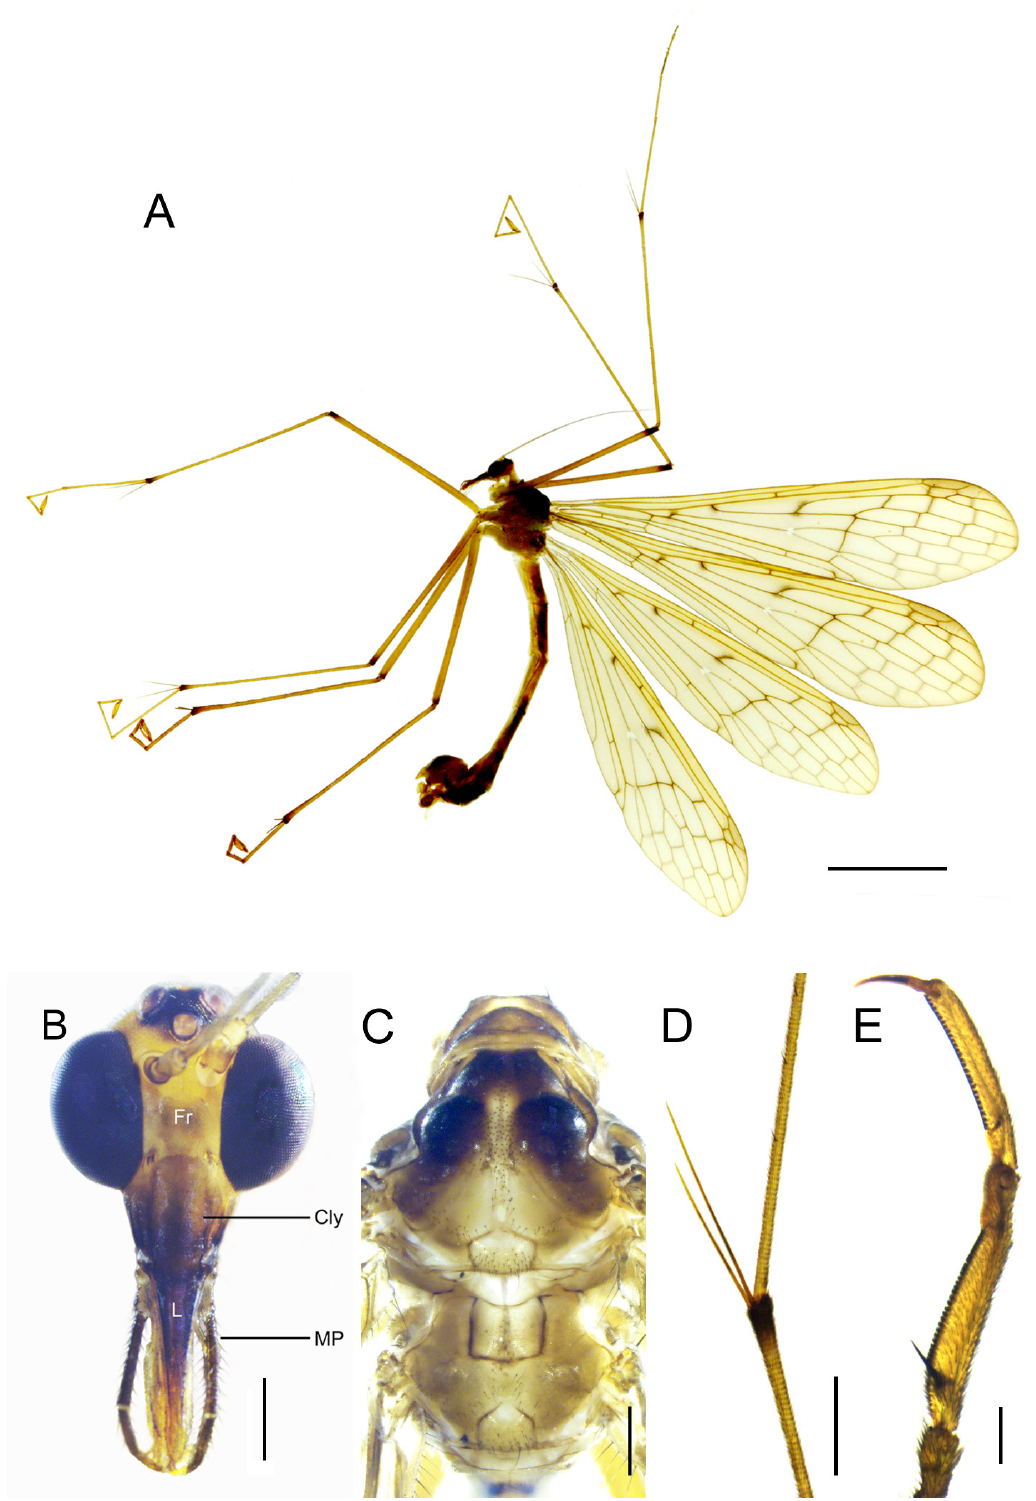
Fig. 2. Bittacus dilobus sp. nov., ♂, holotype (NWAU). A . Habitus in lateral view. B . Head in frontal view. C . Thorax in dorsal view. D . Tibia with two apical tibial spurs of left foreleg. E . Tarsomeres IV, V and claw of left foreleg. Abbreviations: see Material and methods. Scale bars: A = 5.0 mm; B–C, E = 0.5 mm; D = 1.0